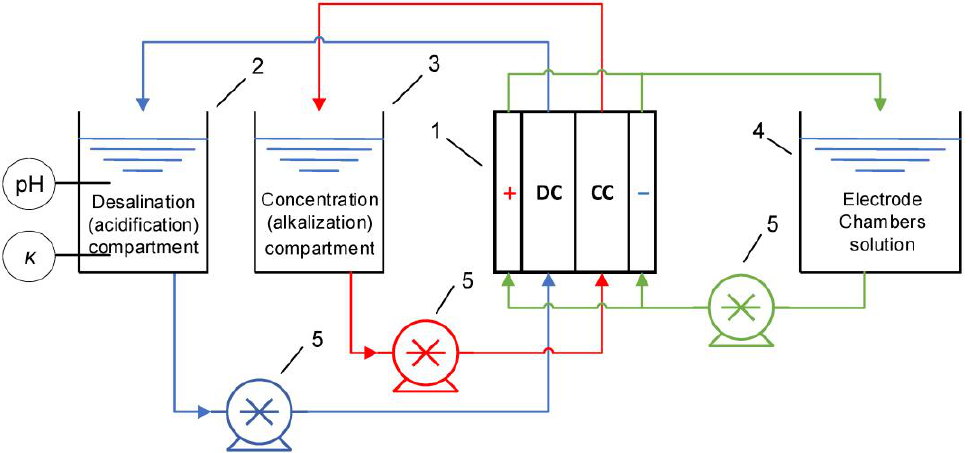
Figure 1. Hydraulic scheme of the electrodialysis setup: 1 — electrodialysis module, 2 — desalination (acidification) compartment tank, 3 — concentration (alkalization) compartment tank, 4 — electrode rinse solution tank, 5 — pumps. DC denotes desalination chamber and CC denotes concentration chamber. Reprinted with permission from Ref. [15] under the terms of the Creative Commons Attribution 4.0 International License (http://creativecommons.org/licenses/by/4.0/ (accessed on 26 December 2022)). Copyright © 2022 by the authors. Licensee MDPI, Basel, Switzerland.